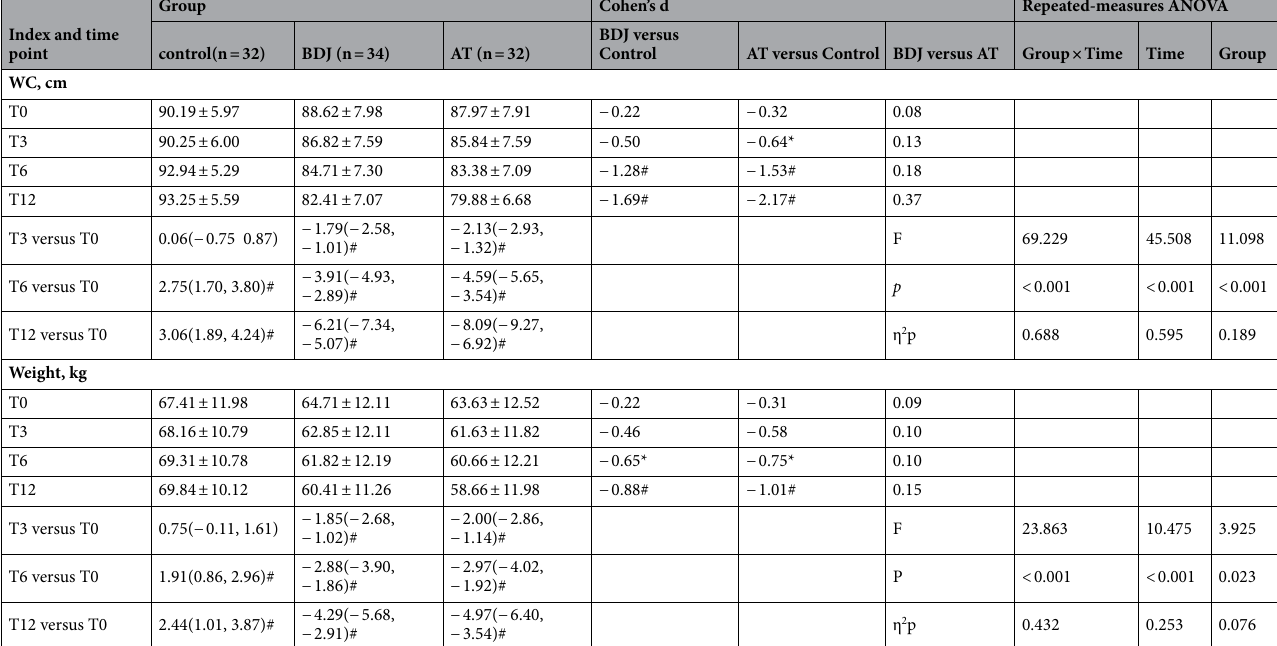
Table 4. Effects of interventions on body shape indicators among the three groups [mean ± SD or mean difference (95% CI)]. Abbreviations: BDJ, Baduanjin; AT, aerobic training; WC, waist circumference; η 2 p, partial eta-squared; T0, baseline; T3, at 3 months; T6, at 6 months; T12, at 12 months; *, significant difference at p < 0.05; #, significant difference at p <